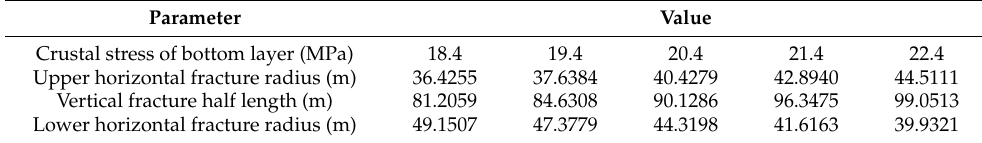
Table 4. Fracture geometry changes with crustal stress of bottom layer.